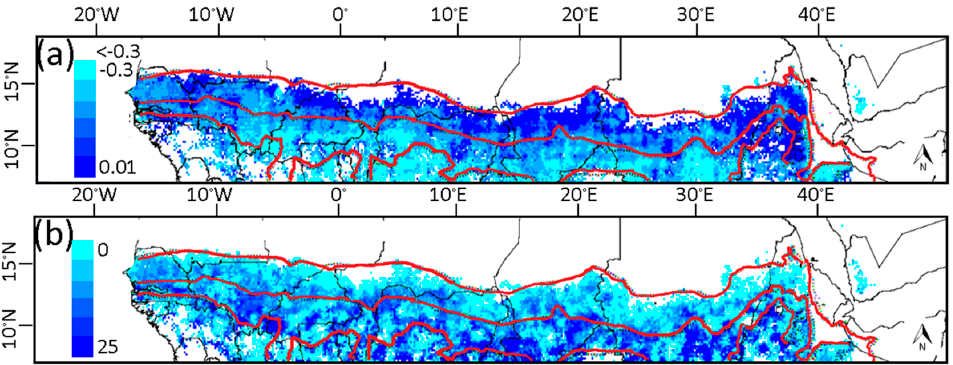
Figure 7. Coefficients of ( a ) seasonal rainfall variance, and ( b ) seasonal rainfall skewness obtained from the multivariate regressions of growing season Σ NDVI on total seasonal precipitation, precipitation variance and skewness. Missing values (white pixels) are areas with high multicollinearity between explanatory variables, or where the coefficients were insignificantly different from zero ( p > 0.05). The red lines from north to south are the 300 mm, 700 mm and 1100 mm rainfall isohyets.